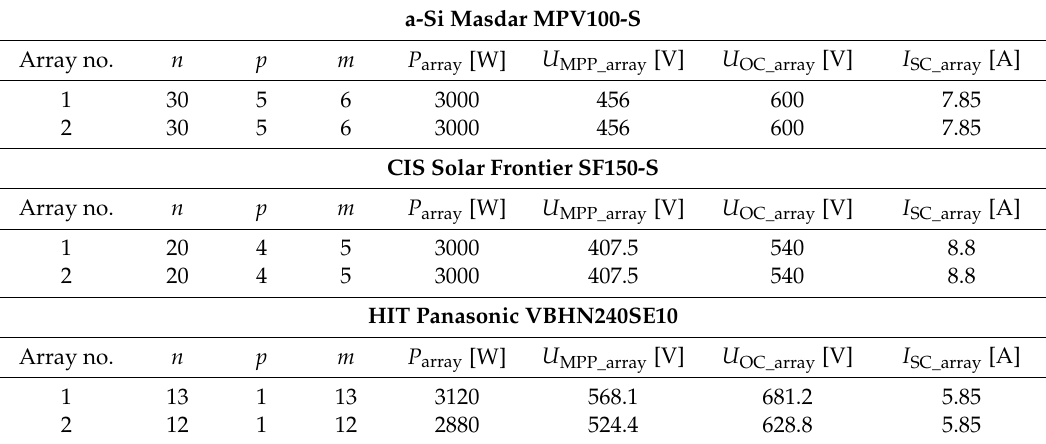
in Table 3. Configurations of PV plant arrays made of a-Si Masdar MPV100-S and CIS Solar Frontier SF150-S are determined by means of the algorithm described in Section 4.1, while configuration of PV plant arrays made of HIT Panasonic VBHN240SE10 PV modules is slightly modified, since PV arrays have a di ff erent number of PV modules (13 and 12 PV modules) in order to satisfy nominal output power of 6 kW. Table 3. Configurations of a di ff erent technology based 6 kW PV